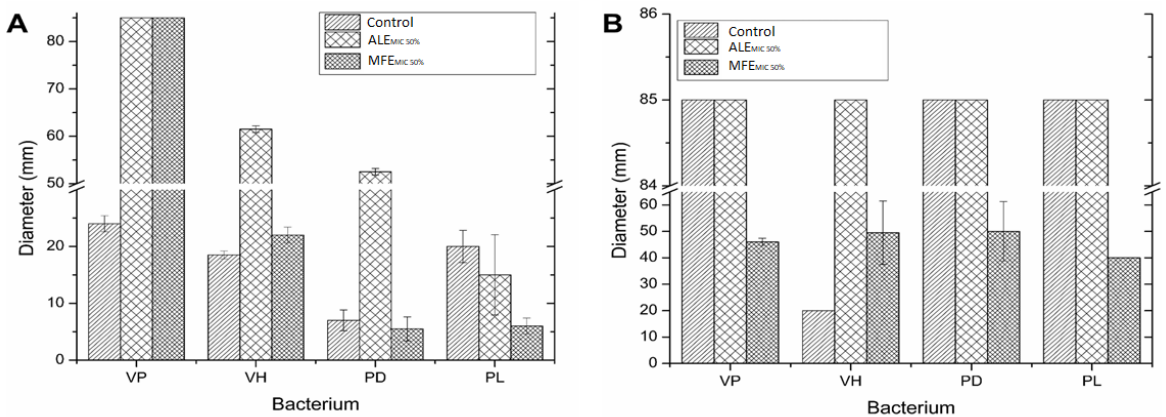
Figure 3. Effect of the extracts on V. parahaemolyticus (VP), V. harveyi (VH), P. damselae (PD), and P. leiognathid (PL) motility. ( A ) Swarming and ( B ) swimming motility. The ALE increased the swarming motility of V. parahaemolyticus , V. harveyi , and P. damselae on 254.17, 232.43, and 650%, respectively. In contrast, P. leiognathi had a reduction of 25%. On the other hand, MFE increased the swarming motility of V. parahaemolyticus , V. harveyi , and P. damselae by 87.5, 18.92, and 21.42%, respectively. However, P. leiognathi decreased its swarming motility by 70% in the presence of MFE (Figure 3A).